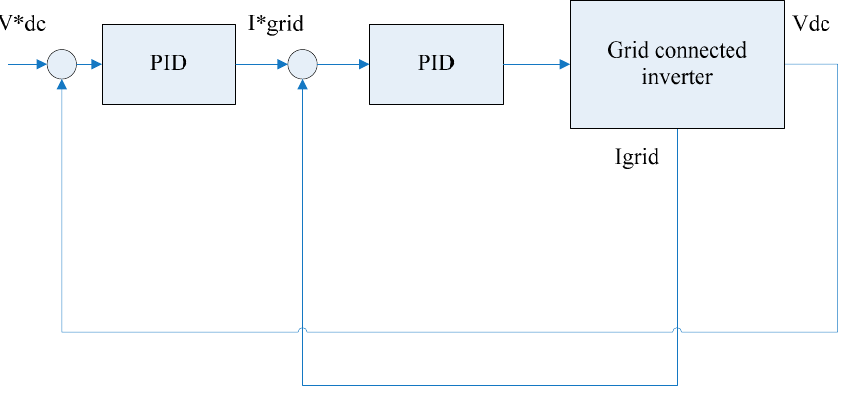
Figure 2. Block diagram of a PID control system for I grid and V dc .